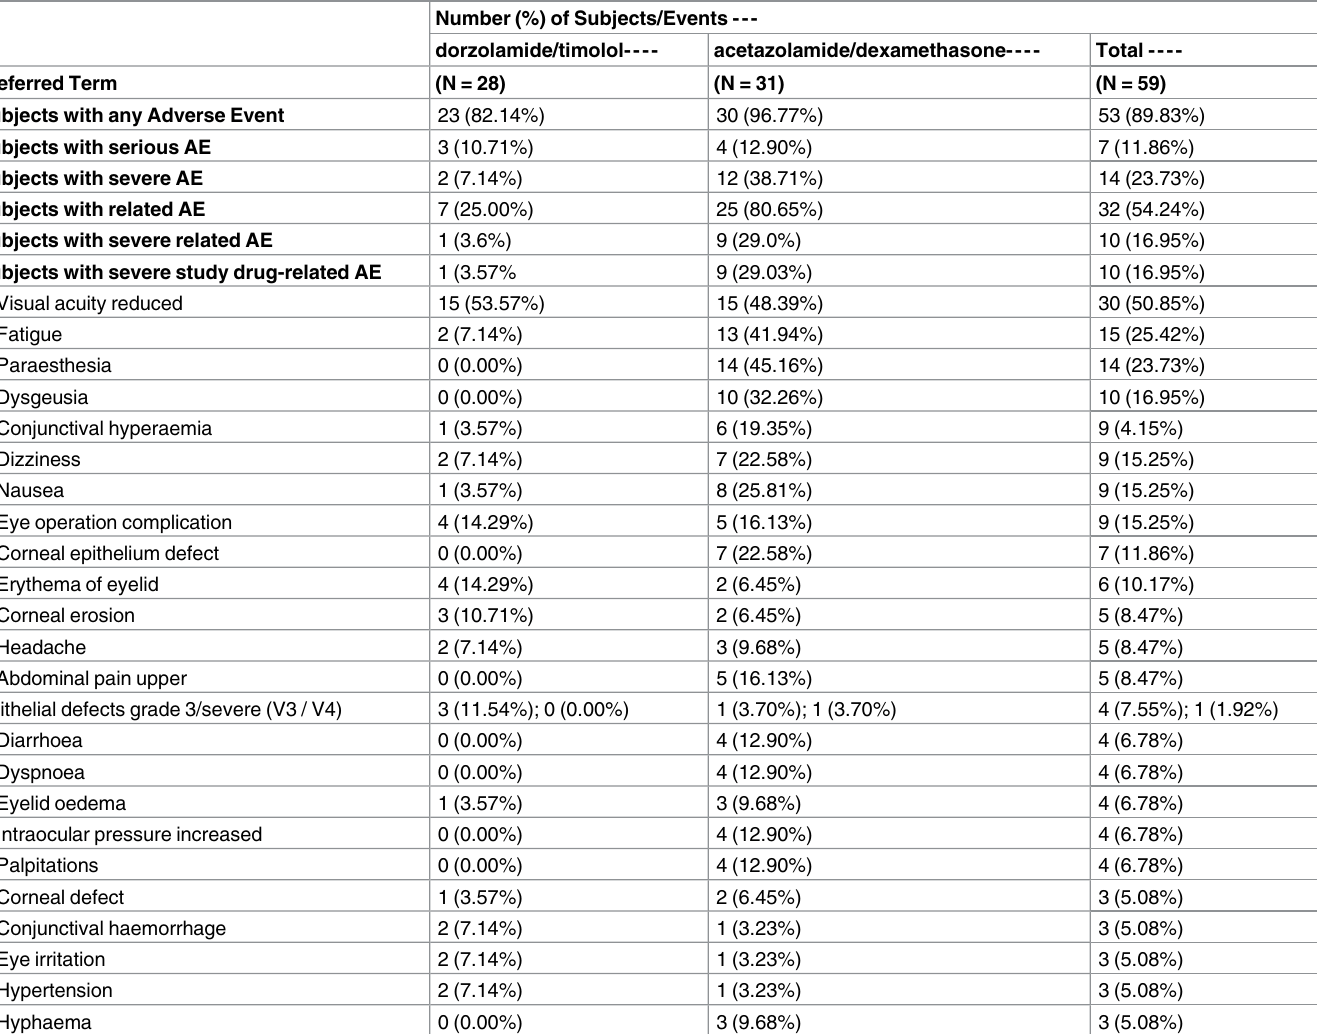
Table 7. Adverseevents—safety population (N =